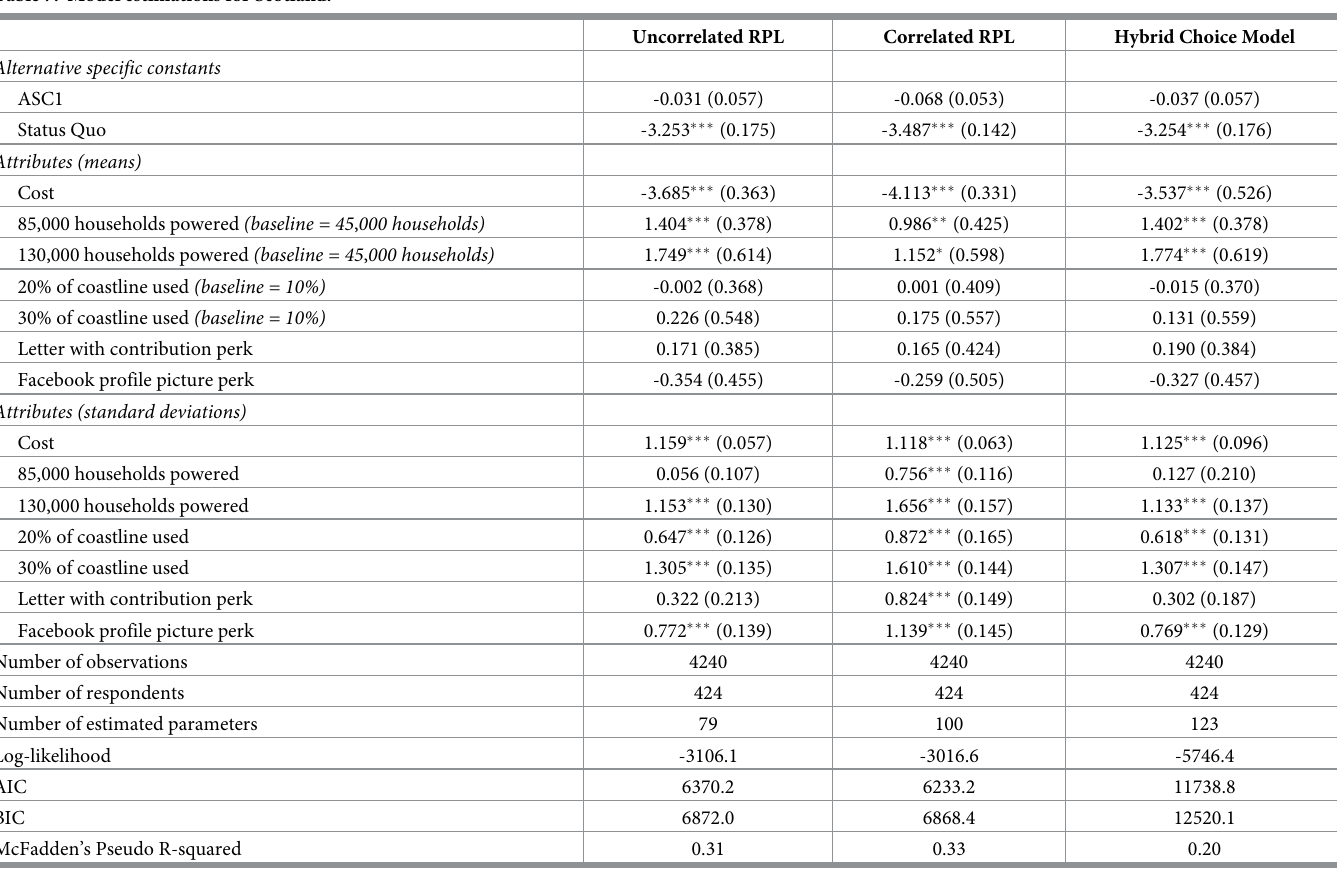
Table 7. Model estimations for